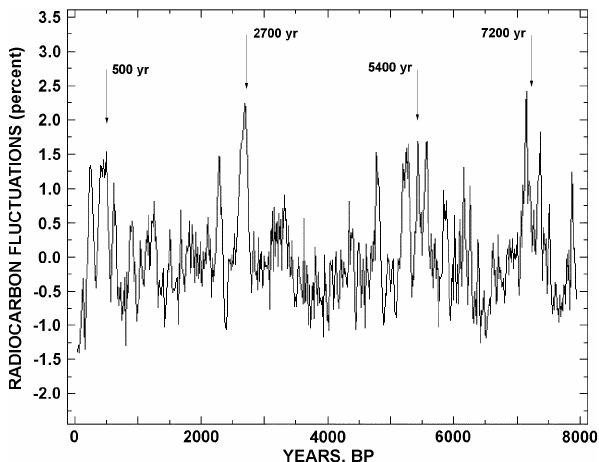
Fig. 2. The domains of high amplitude (dark areas) on the frequen- cy-time plane found in the radiocarbon data by the multiple filtra- tion method. The epochs of fluctuations with high amplitude are re- peated each 2300–2500 years. The cyclic curve is the result of low frequency filtration with maximum frequency 0.00066